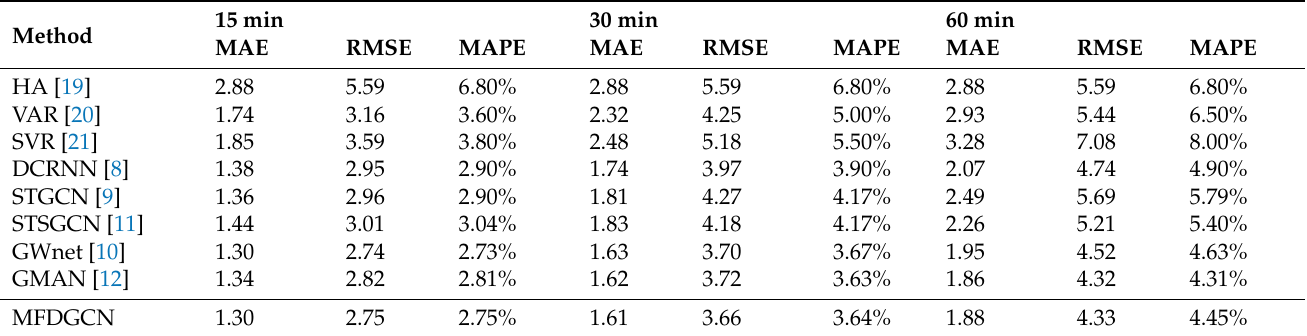
Table 1. Comparison of 15, 30, and 60 min traffic prediction performance between MFDGCN and baseline models on the PEMS_BAY data